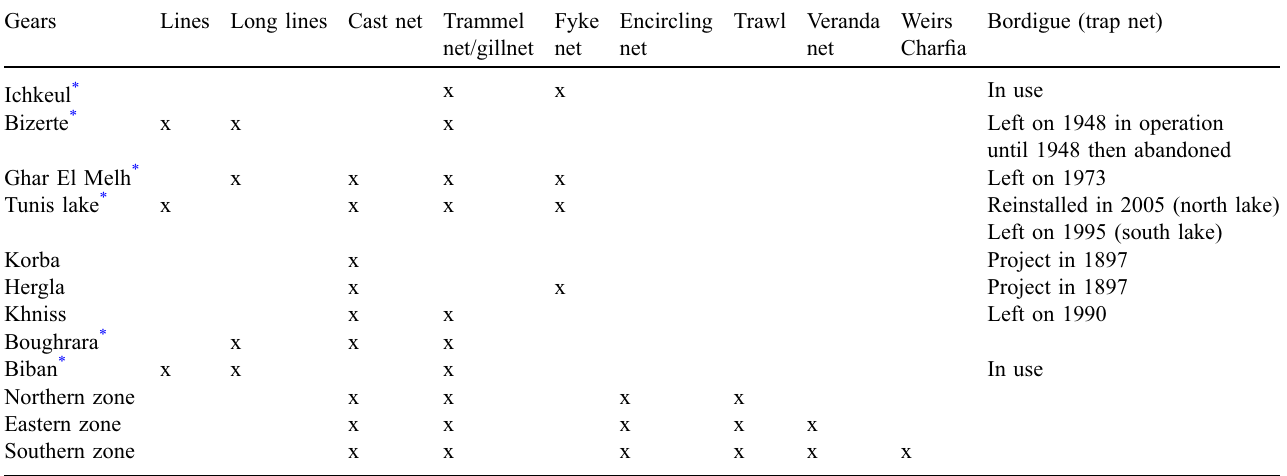
Table 5. Fishing gears used in Tunisian lagoons and coastal areas. Gears Lines Long lines Cast net